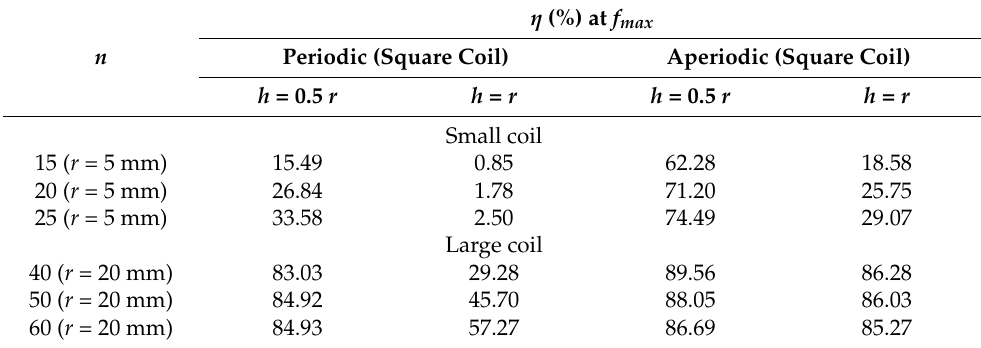
Table 6. The values of the power transfer efficiency at f max = 1 MHz for a square coil (periodic and aperiodic).